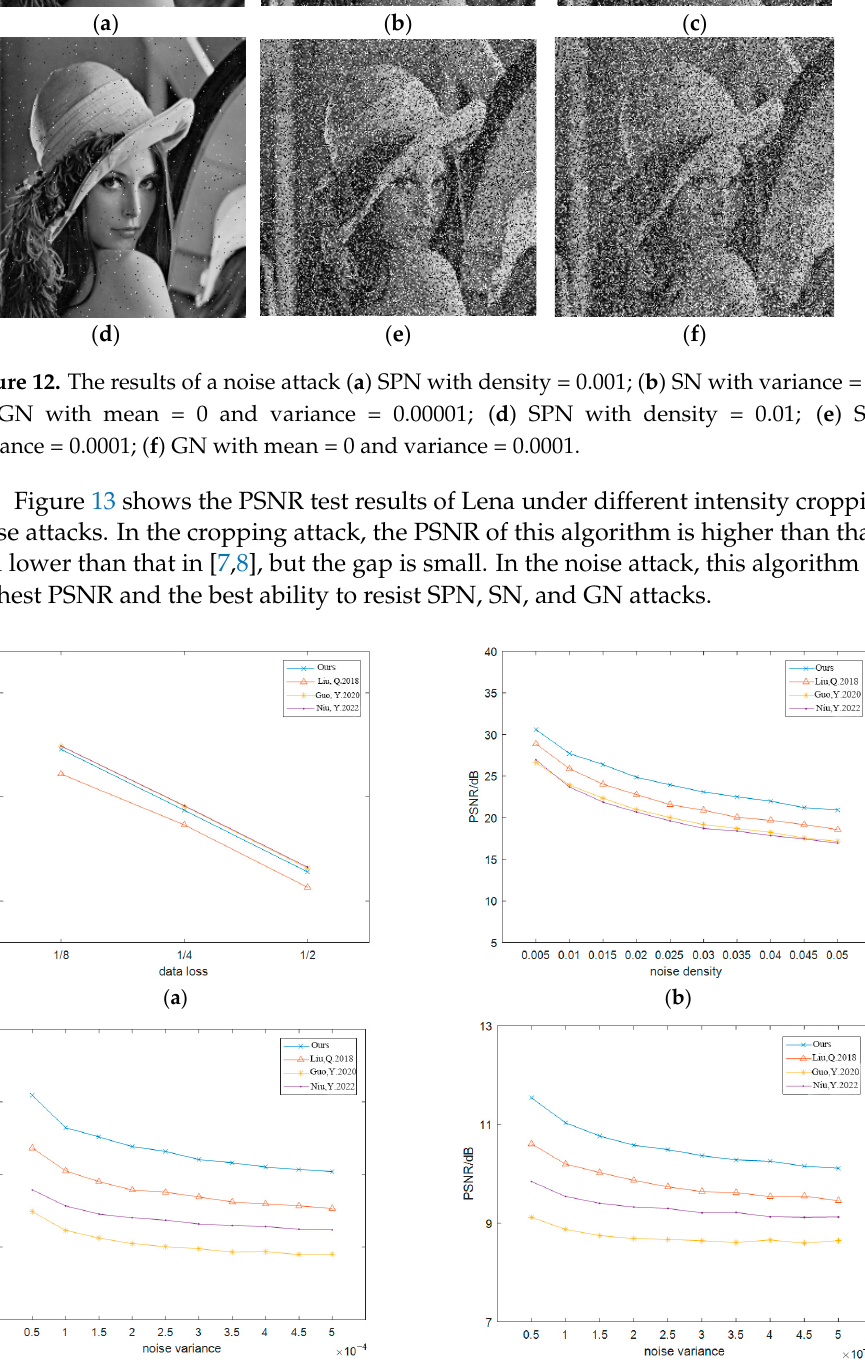
Figure 12. The results of a noise attack ( a ) SPN with density = 0.001; ( b ) SN with variance = 0.00001; ( c ) GN with mean = 0 and variance = 0.00001; ( d ) SPN with density = 0.01; ( e ) SN with variance = 0.0001; ( f ) GN with mean = 0 and variance = 0.0001.